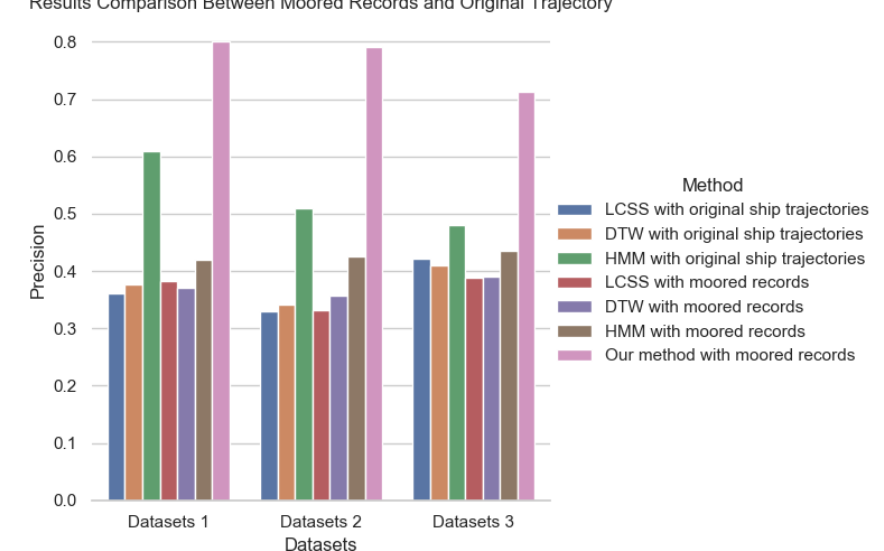
Figure 5. Results comparison of ship classification under moored records and original ship trajectories.